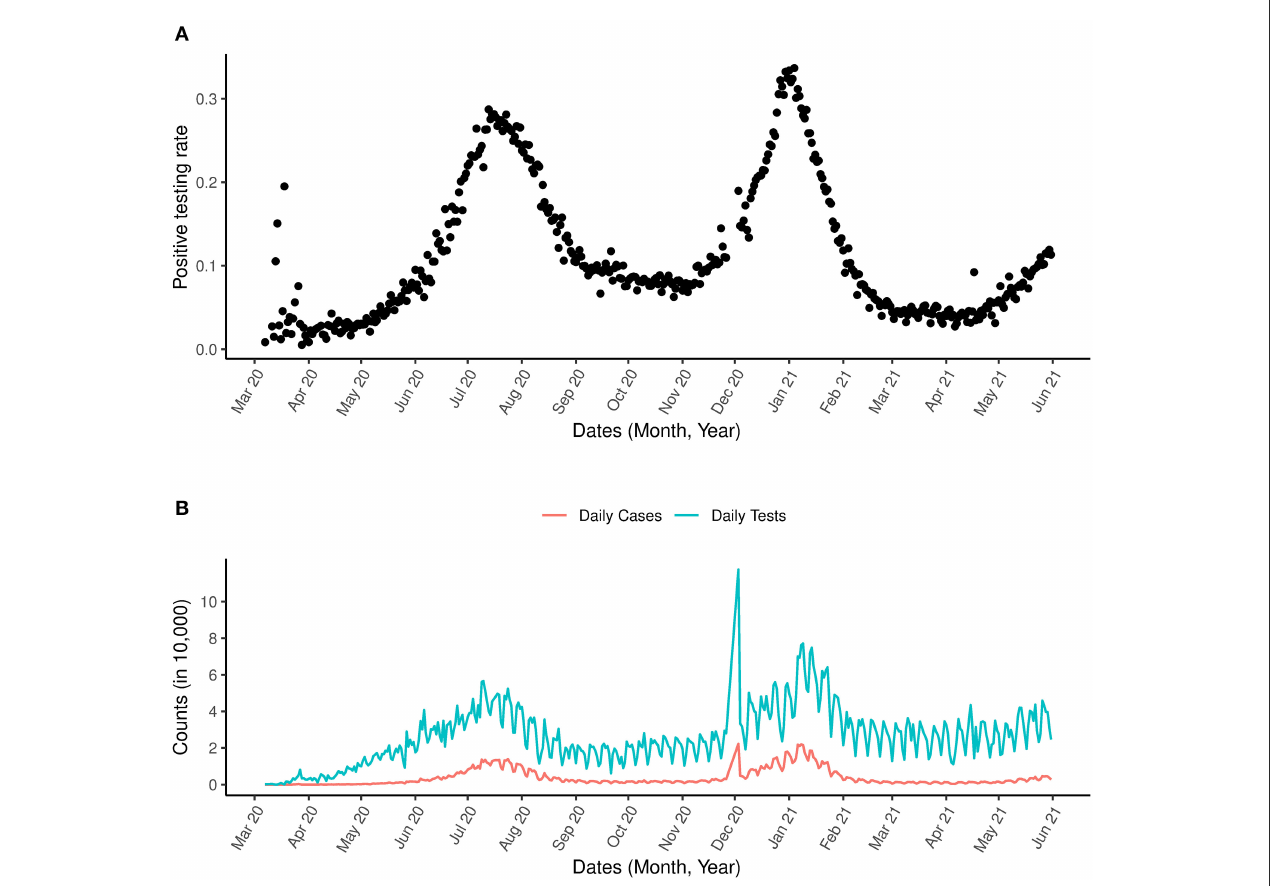
FIGURE3 COVID-19 and positive testing rate. (A) Is the positive testing rate. (B) Is the daily number of cases and daily number of COVID-19 tests between March 1st, 2020 and May 31st,